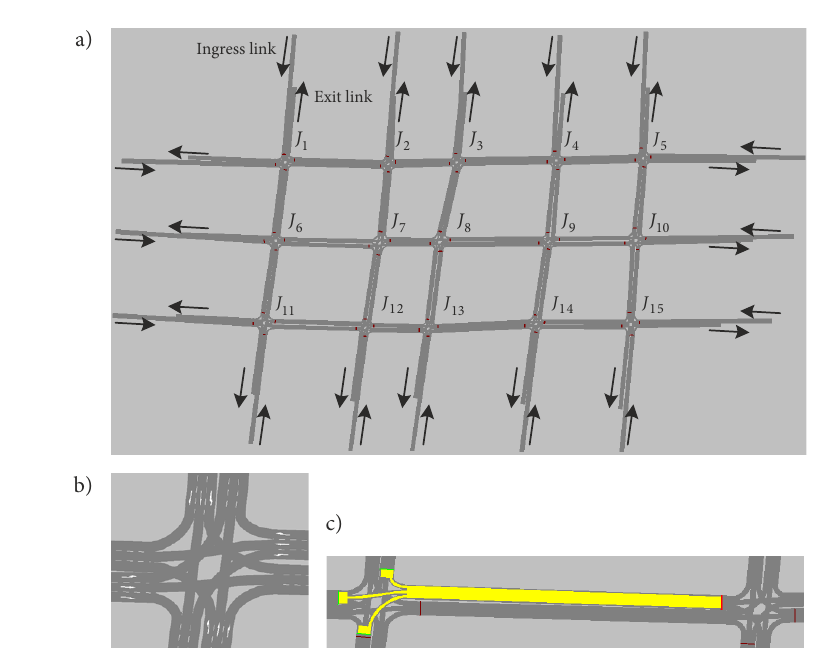
Figure 4. Simulation traffic network in Vissim : a – topology of simulation traffic network; b – link connection of an intersection; c – route decision on a